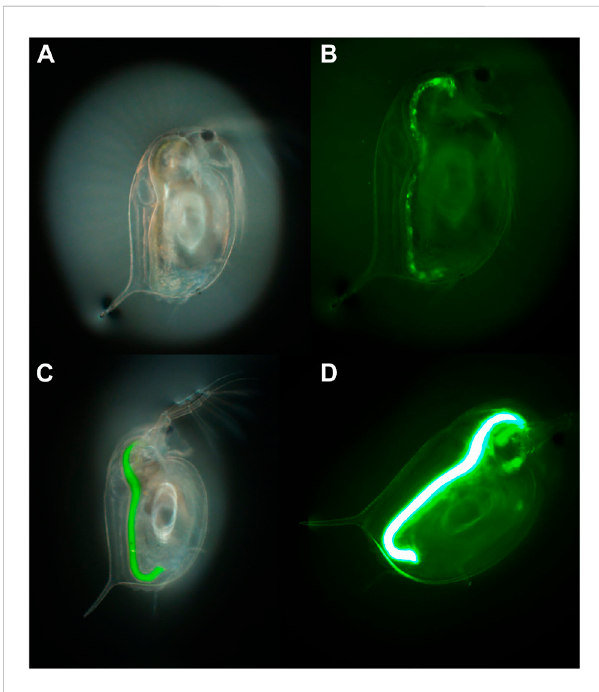
FIGURE 2 An example of the use of fl uorescence to determine uptake of 1 – 5 µm polyethylene MP particles by D. magna visualised in two daphnids exposed to different concentrations of the MPs (50 and 500 mg/L, respectively) for 24 h. (A,C) bright fi eld, and (B,D) fl uorescence imaging of the fi rst and second daphnids, respectively. Taken with an Olympus optical microscope with a Green Fluorescent Protein (GFP) fi lter cube and dichroic mirror and a DP74 colour camera and viewed using CellSens software (×70 magni fi